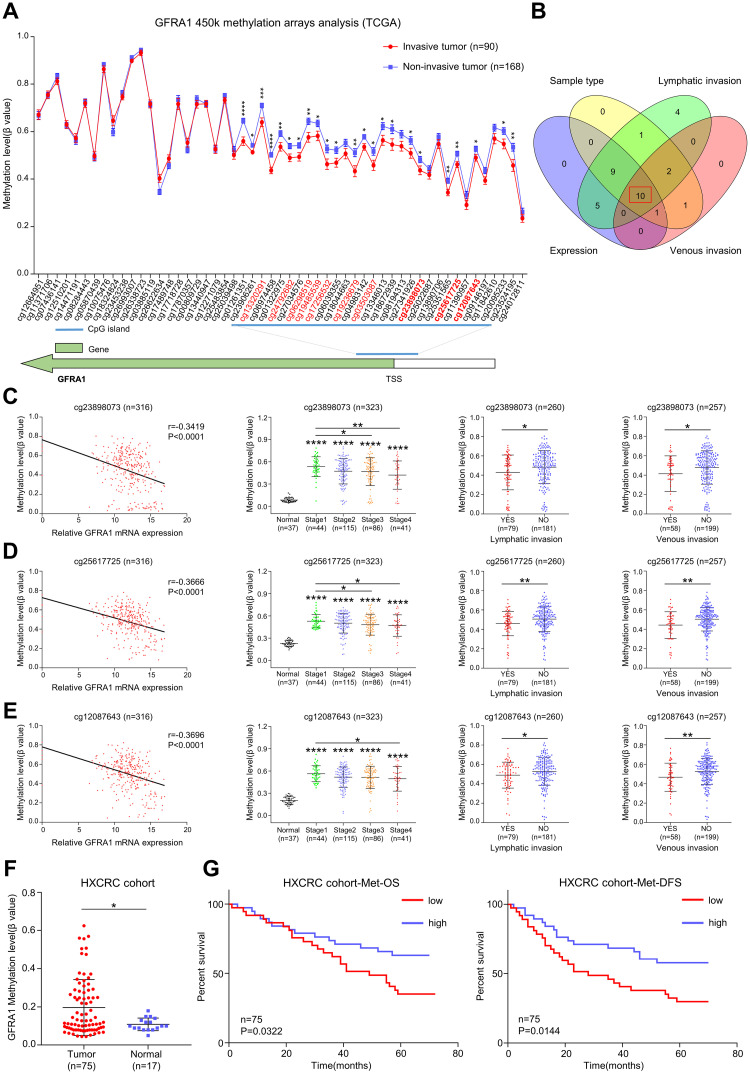
Analysis of full-length methylation modification of GFRA1 gene in CRC based on 450K methylation microarray.A Full-length 450K methylation array data analysis of GFRA1 gene in invasive CRC tumors compared to non-invasive CRC tumors (*p < 0.05, **p < 0.01, ***p < 0.001, ****p < 0.0001; student t-test, Data are mean ± SEM). B Venn diagram used to demonstrate a common list of 10 methylated sequences. Including the correlation between the probe sequences DNA methylation level and gene expression (r < -0.3; Pearson’s correlation test, Expression), the methylation modification of probe sequences in CRC (p < 0.05; student t-test, Sample type), significant reduction of DNA methylation level in lymphatic invasive CRC (p < 0.05; student t-test, Lymphatic invasion)and vascular invasive CRC (p < 0.05; student t-test, Venous invasion). marked in red (A). C-E Detailed description of three methylation sequences upstream of GFRA1 gene TSS from (B), including correlation between gene expression and DNA methylation (Pearson’s correlation test), variety in DNA methylation levels at different tumor stages (*p < 0.05, **p < 0.01, ****p < 0.0001; student t-test) and differences in methylation levels between invasive and non-invasive tumors (*p < 0.05, **p < 0.01; student t-test). F Comparison of the methylation levels of GFRA1 TSS upstream in CRC tumor tissues and normal tissues from HXCRC cohort (*p < 0.05; student t-test). G Overall and disease-free survival of patients from HXCRC cohort methylation data in (F) (log-rank (Mantel-Cox) test). Data are mean ± SD.